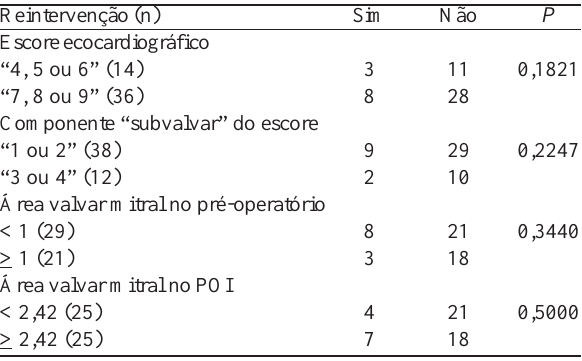
Tabela 1. Análise univariada para reintervenção sobre a valva